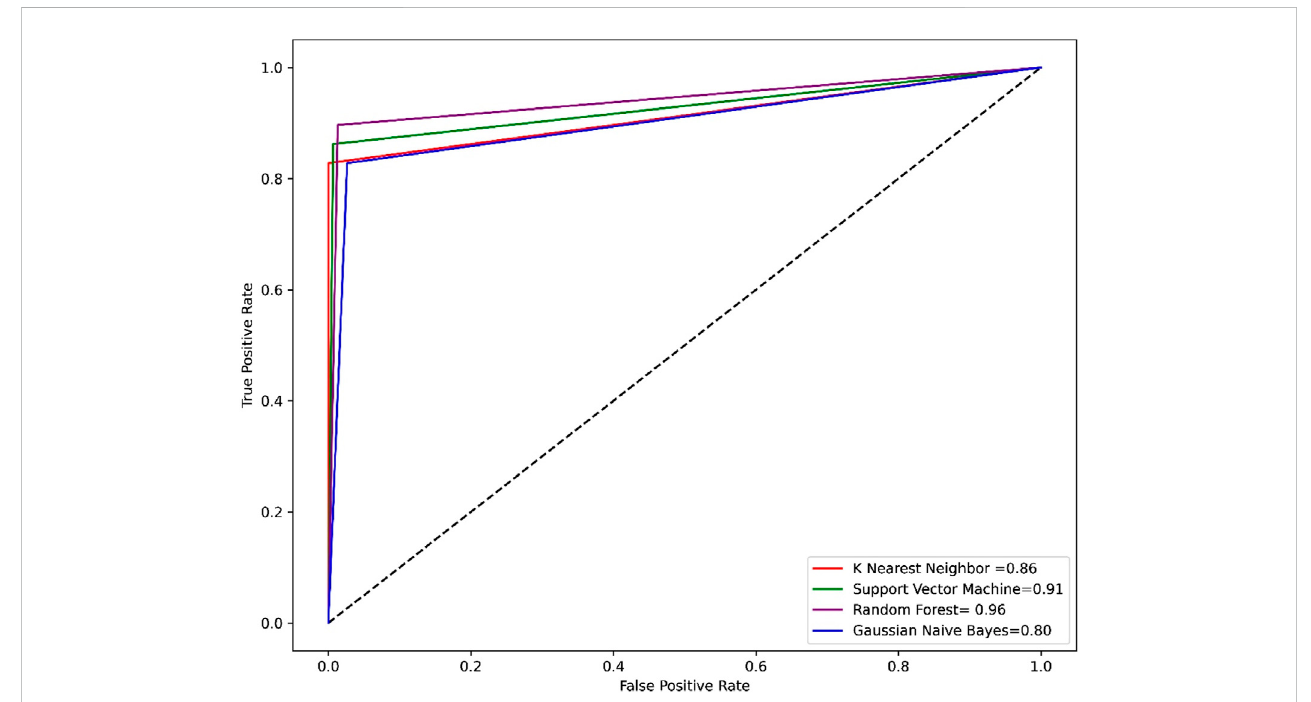
FIGURE 6 ROC-AUC curve of all the models on the test set. The graph shows the TP against FP